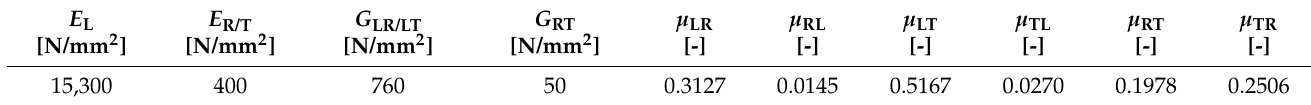
Table 4. Nominal material values for an FE based design calculation of beech LVL